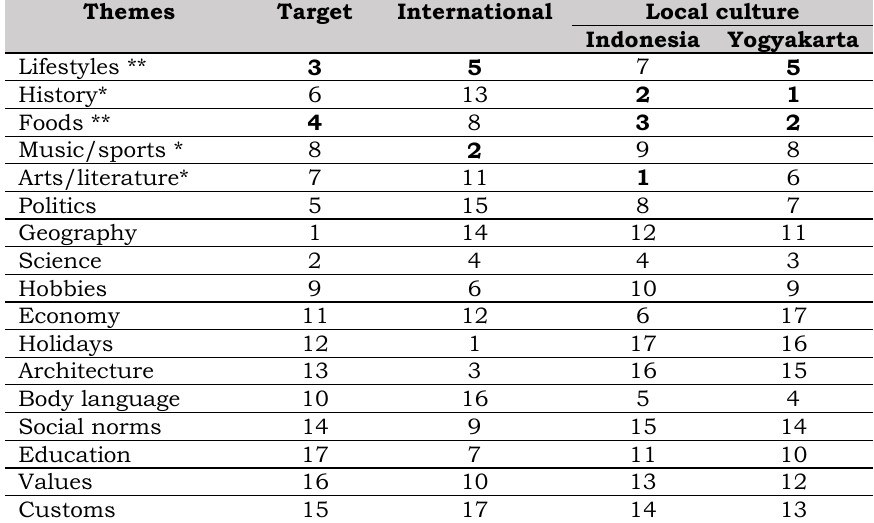
Table 5. Top five preferred cultural themes and